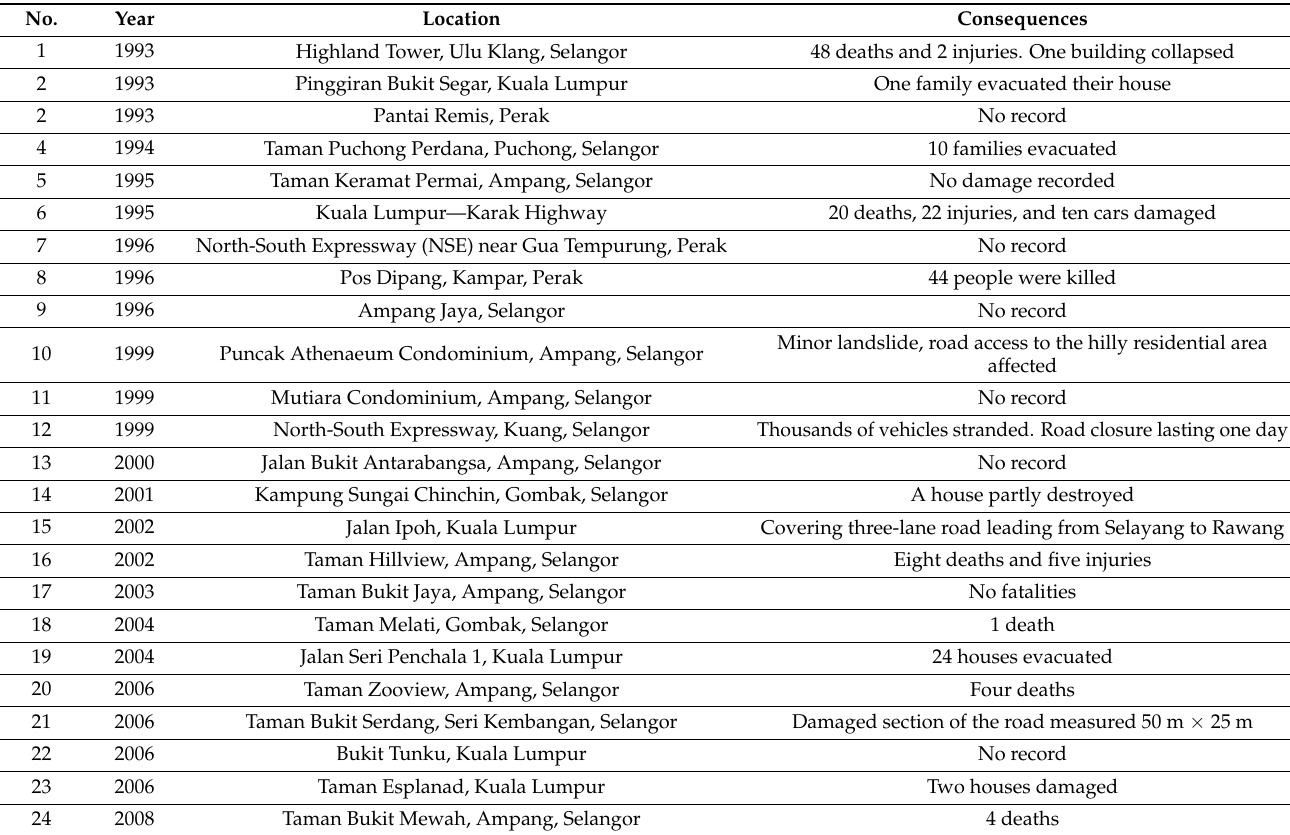
Table 1. Series of significant landslide occurrences in